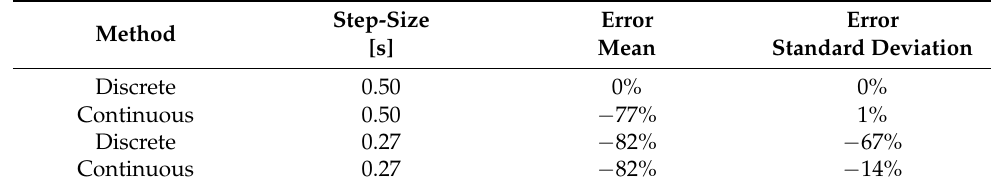
Table 5. Percent performance improvement for continuous and discrete